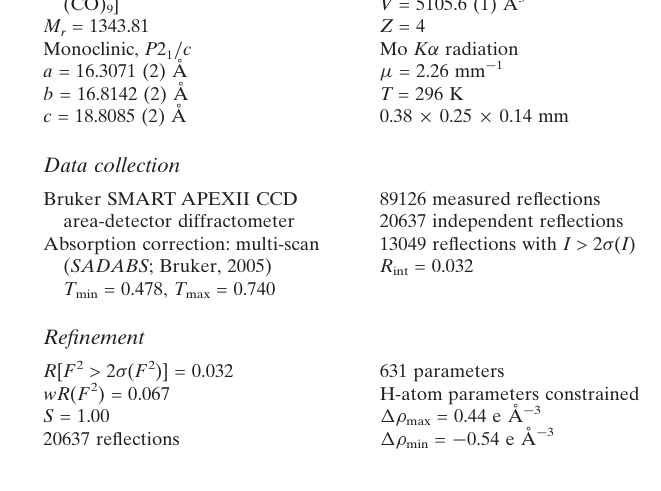
bis(diphenylarsino)methane